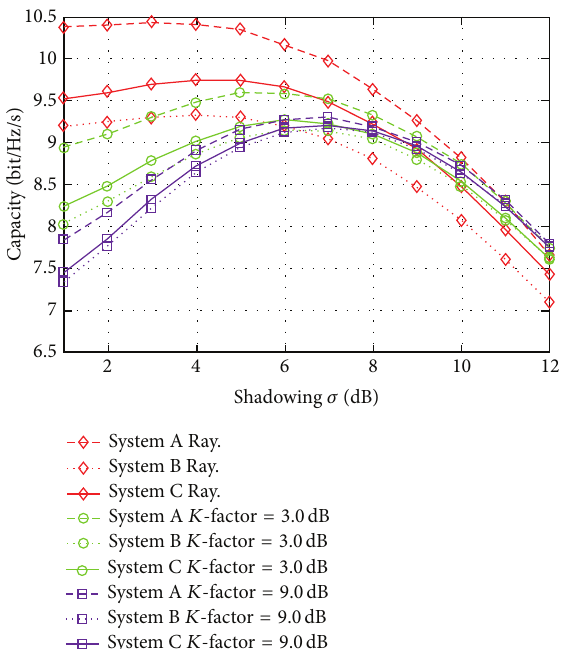
Figure15:DistributedMIMOcapacityforsystemA,B,andCversus shadowing level for composite fading, Rayleigh and Rician (with different 𝐾 -